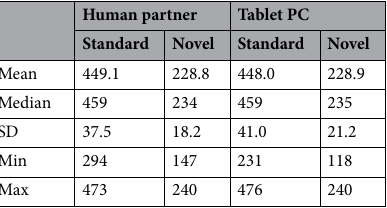
Table 1. Descriptive statistics on the number of included trials per